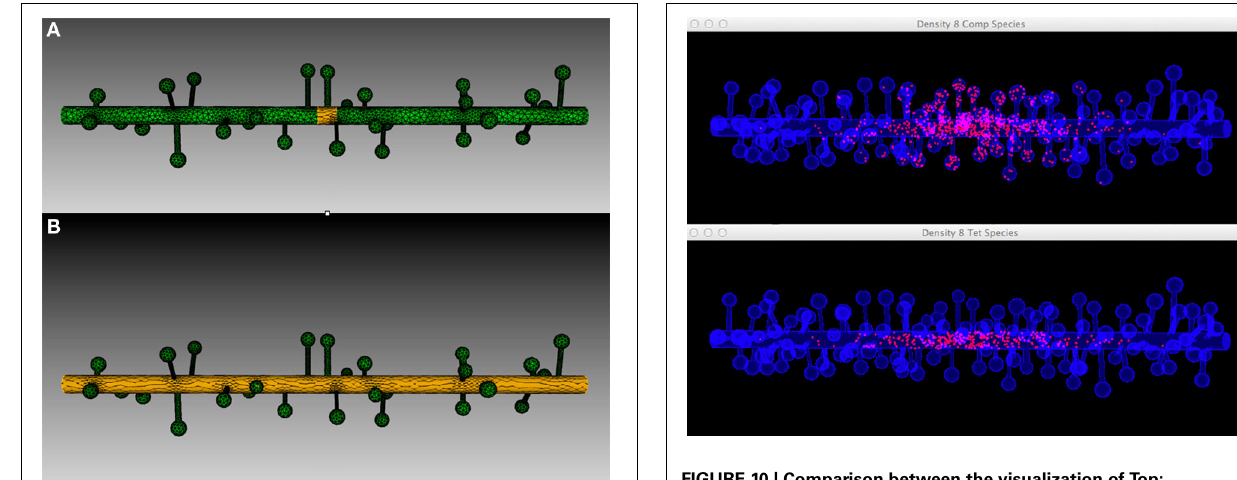
molecule species in multiple displays. The anomalous diffusion example showcases the usage of “Regions of Interest” datasets for visually filtering molecules in a specific region. This exam- ple also demonstrates how multiple simulations are executed and visualized simultaneously for